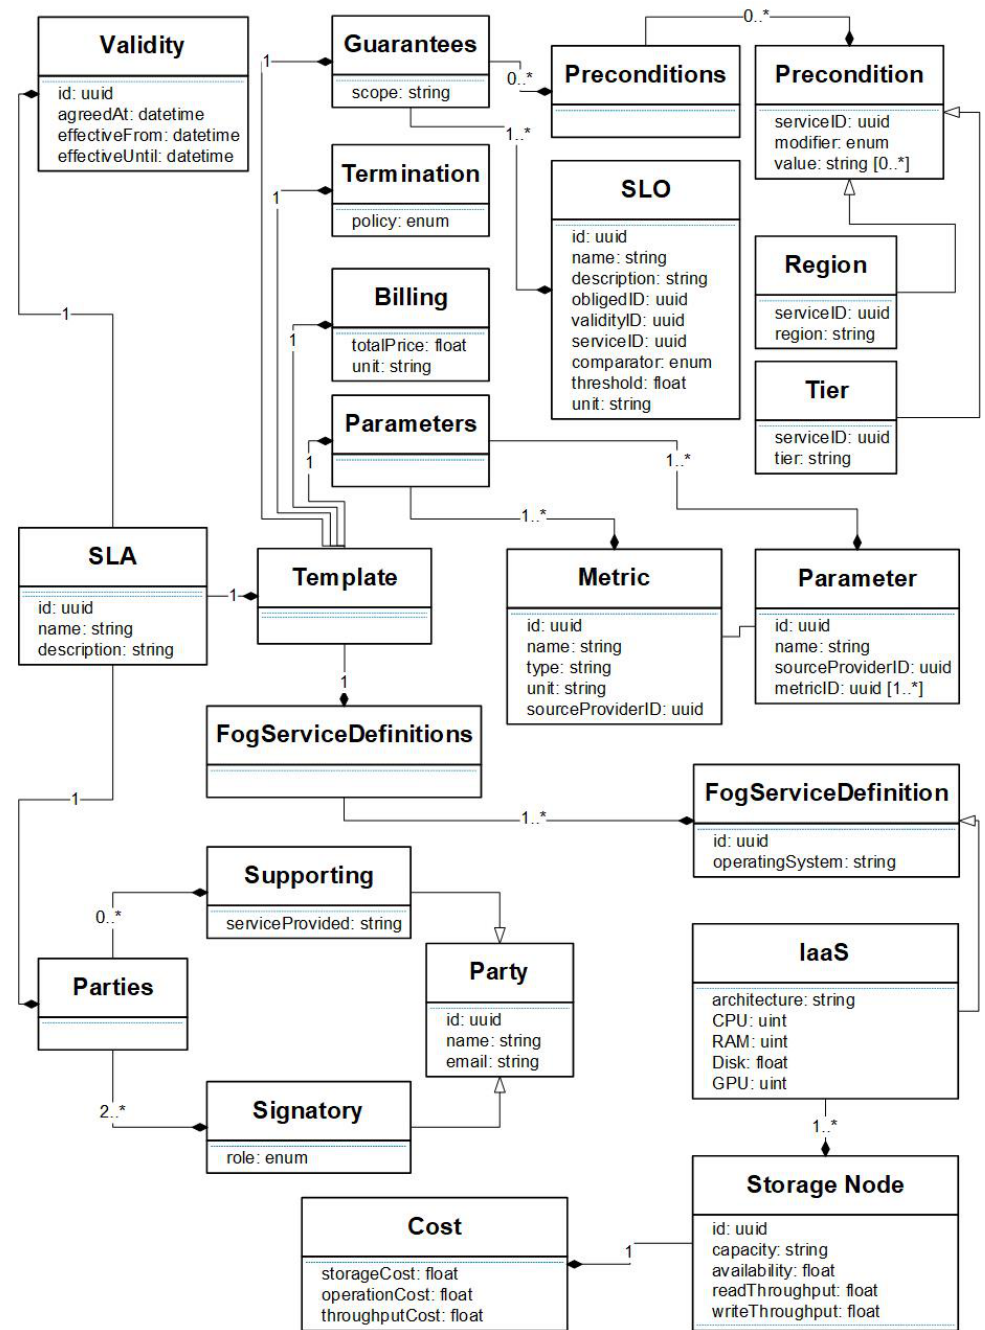
Figure 3. SLA specification diagram for storage in the